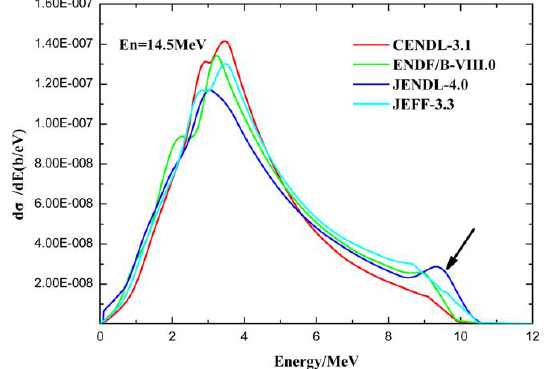
Fig.13 The contributions from the continuum inelastic scattering for iron at the incident neutron energy of 14.5